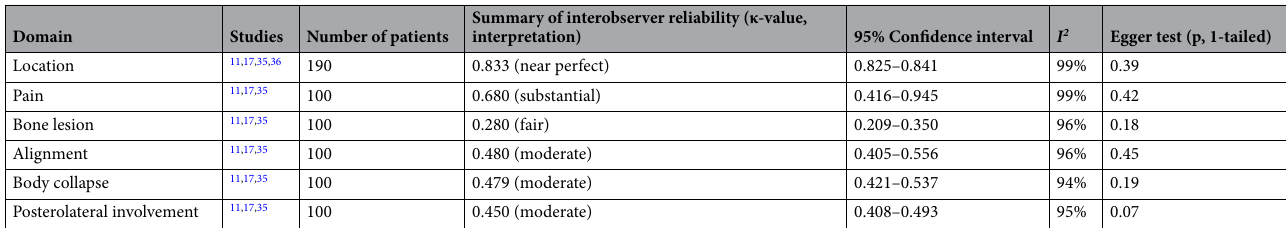
Table 4. Precision of 6 domains of the Spine Instability Neoplastic Score